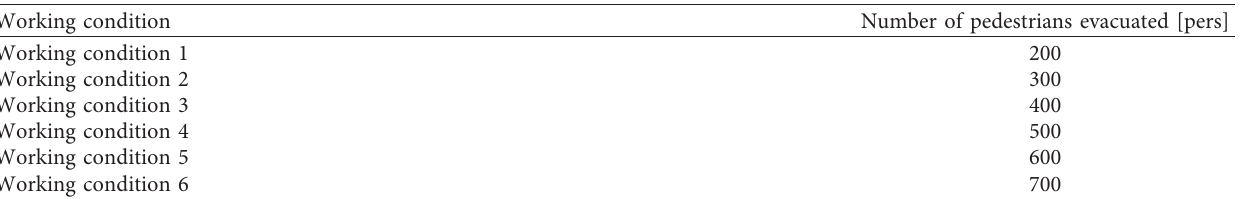
Table 7: Working condition.